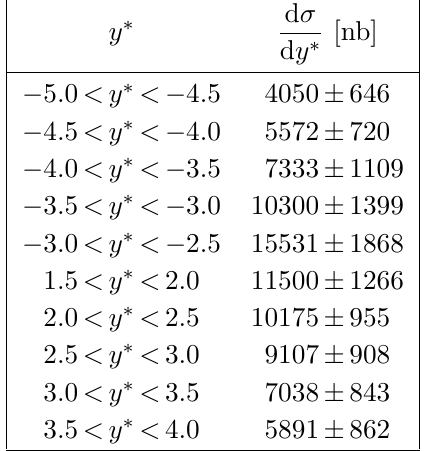
Table 7 . (cid:7) (1 S ) production cross-section in p Pb and Pb p , as a function of y (cid:3) .